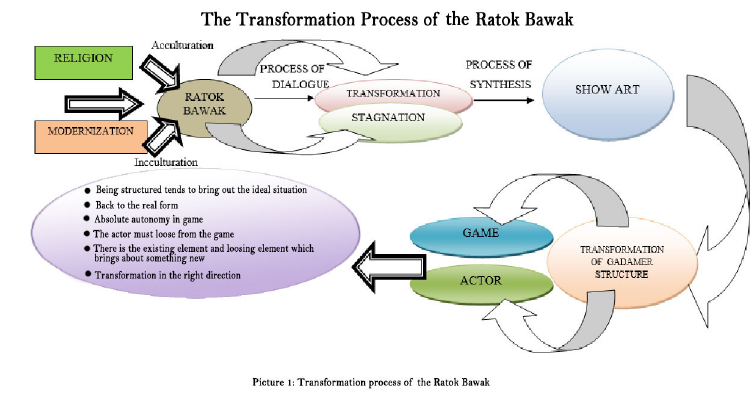
Figure 1. Transformation process of the ratok bawak (source: created by